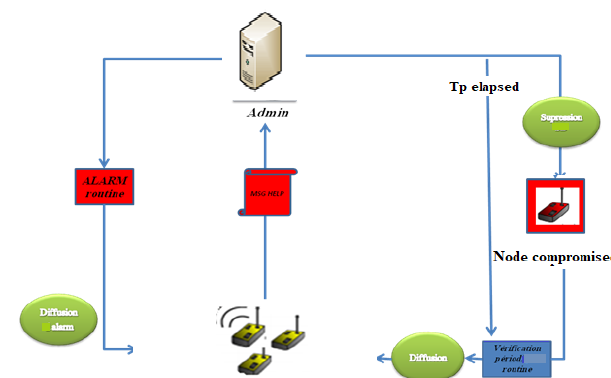
Figure 4. Diagram for the detection of the compromised node